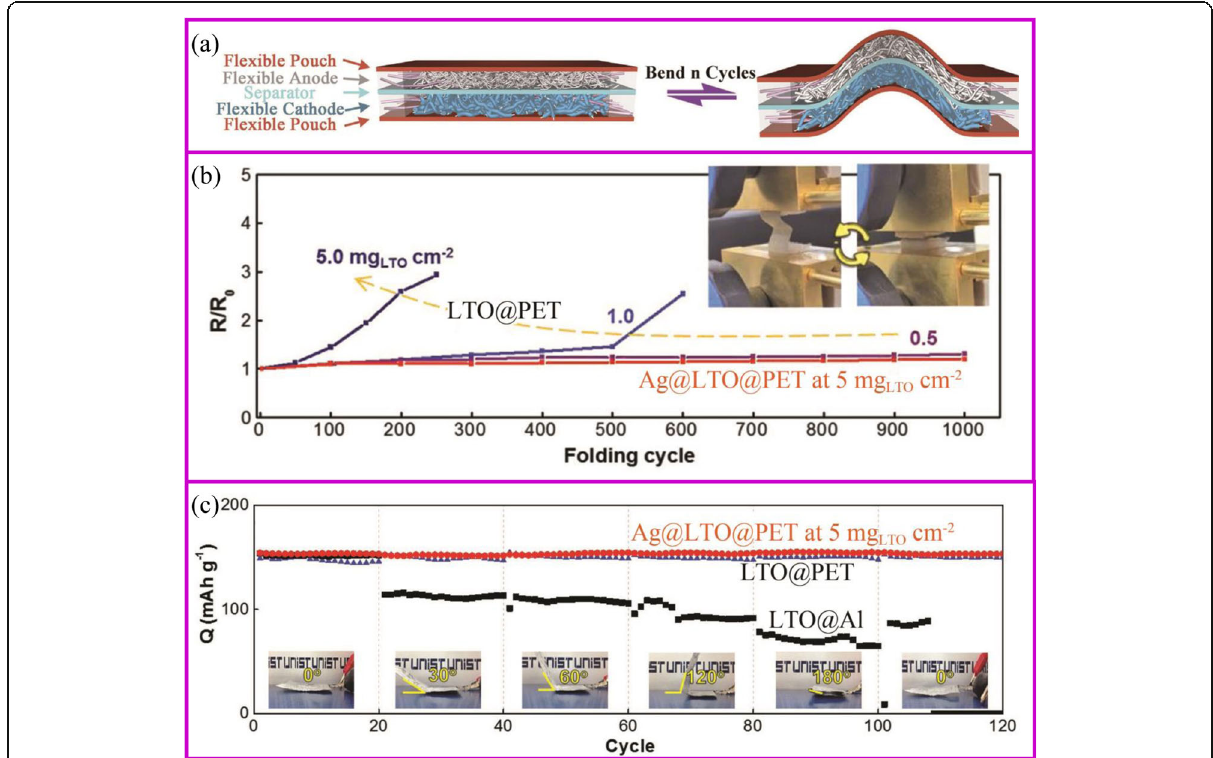
Fig. 10 a Assembly and bending tests of flexible batteries with flexible electrodes [164]. b Electrical resistance change with folding cycles [165]. c